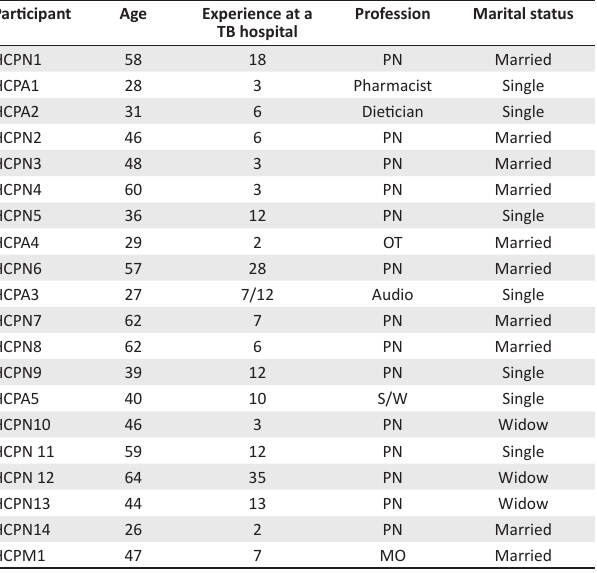
TABLE 1: Demographic profile of the